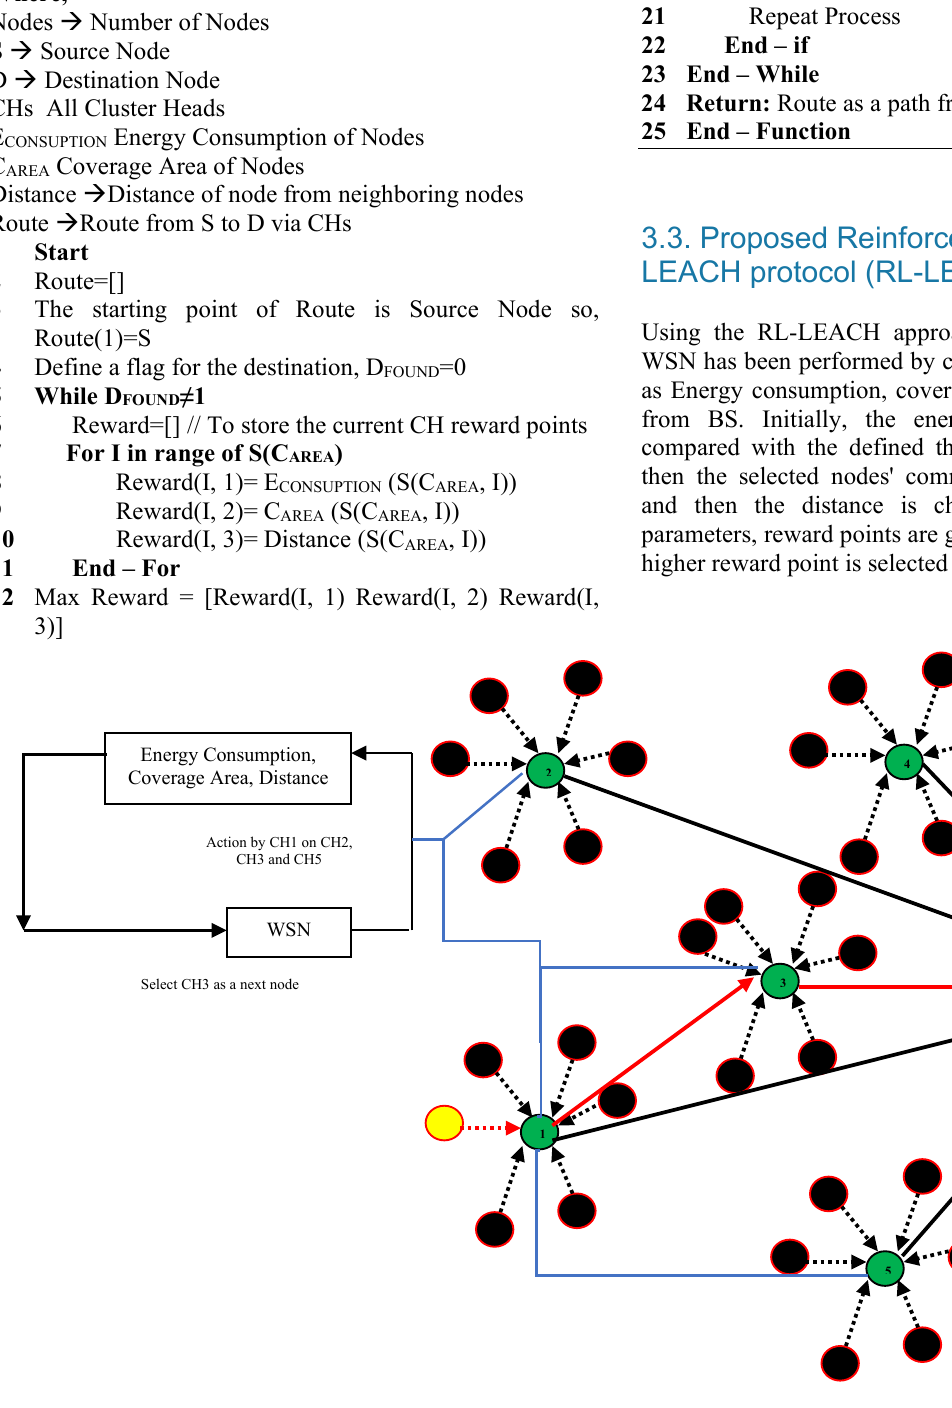
Figure 8. Proposed RL-LEACH approach Working